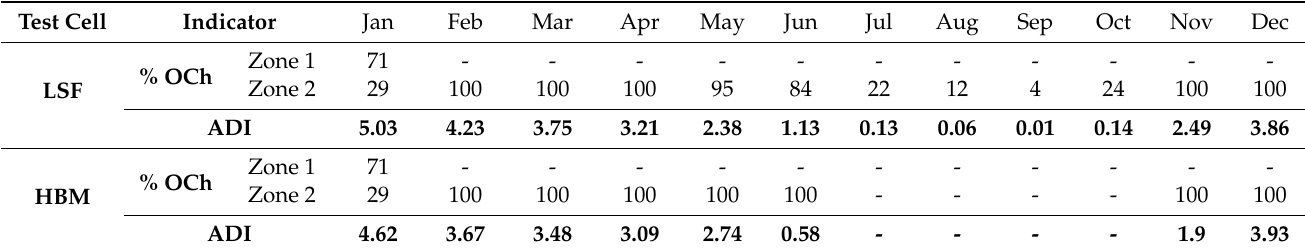
Table 2. Thermal comfort evaluation based on the percentage of hours of overcooling (%OCh) and average discomfort index (ADI)